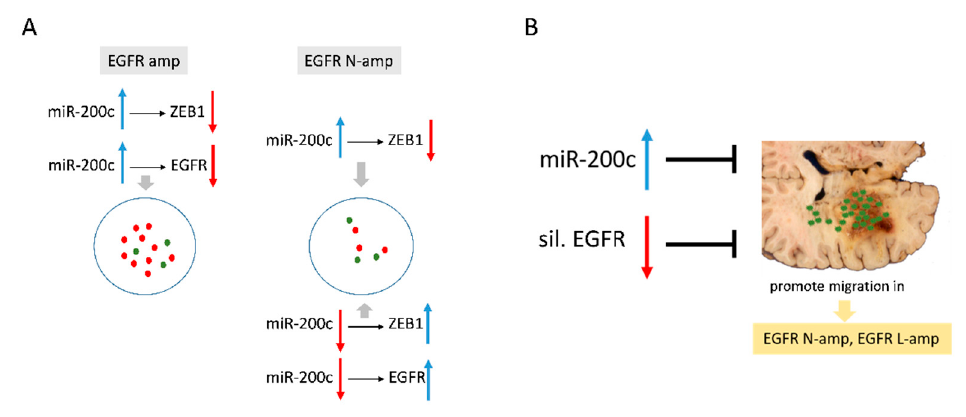
Figure 7. ( A ) MiR-200c modulates ZEB1 and EGFR expression. ( B ) Effects of miR-200c expression and EGFR silencing on cell migration.